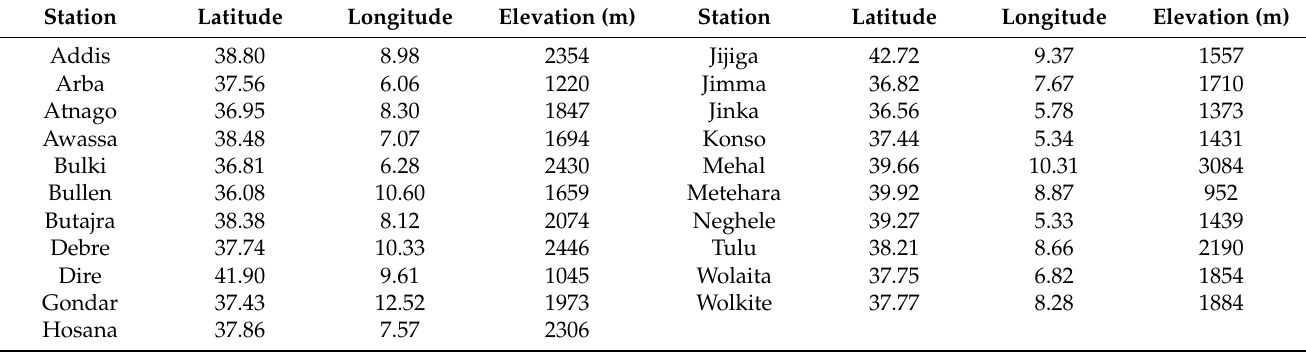
Figure 3. Distribution of meteorological stations in Ethiopia. Table 1. Geographical locations of 21 meteorological stations in Ethiopia.